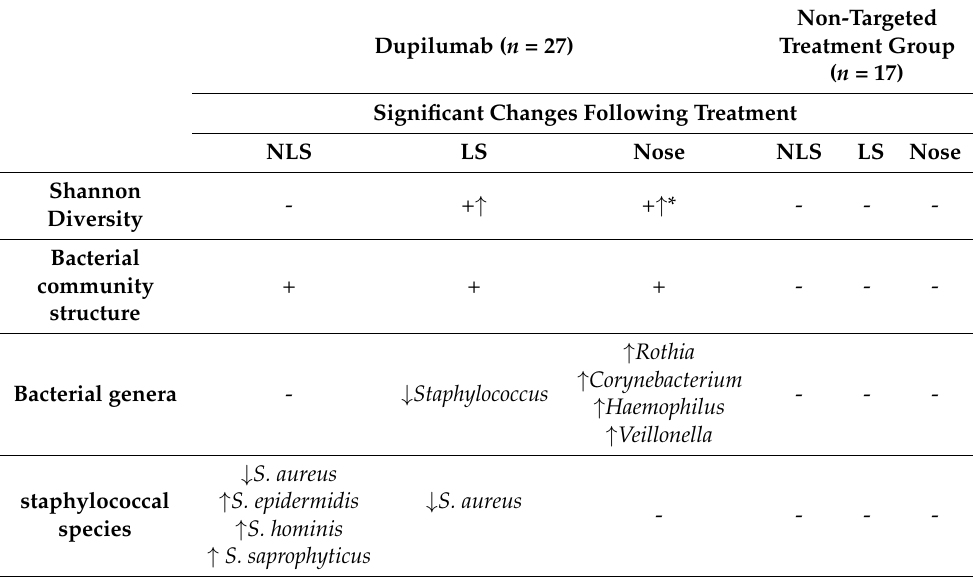
Table 2. Treatment related changes in microbiome and staphylococcal species in the two treat- ment groups 1